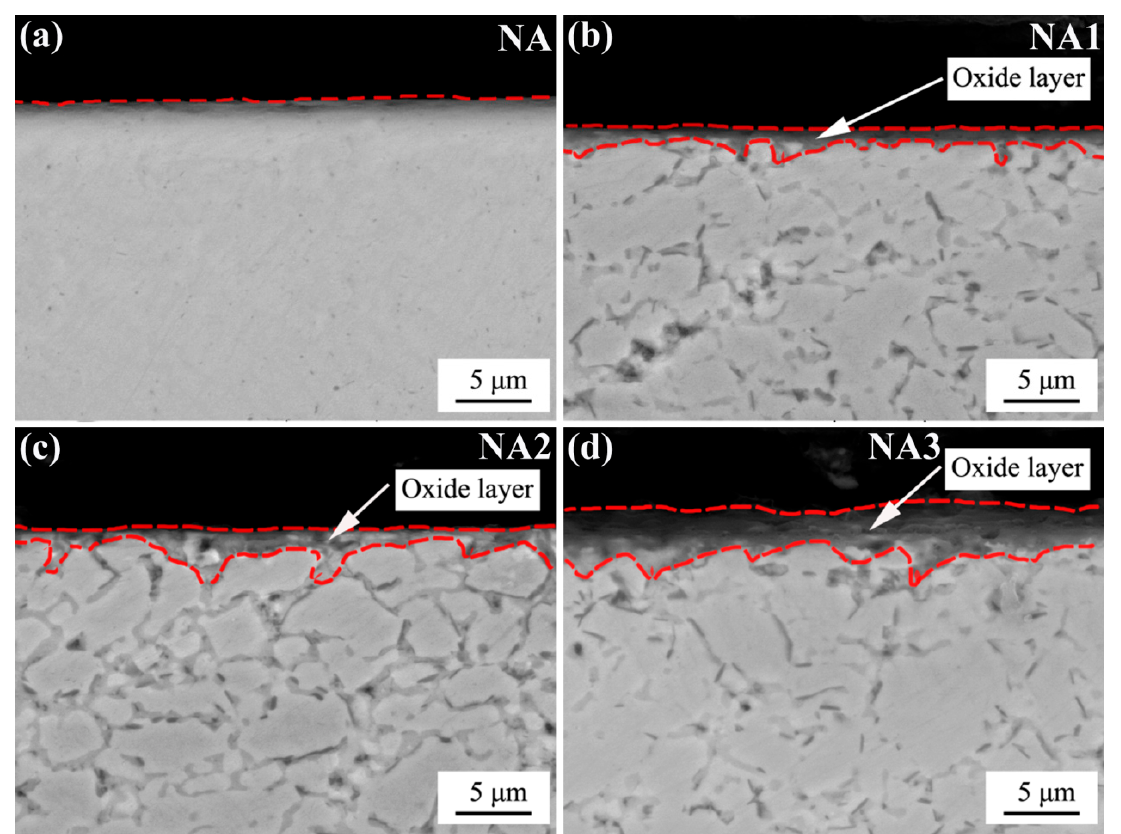
Figure 7. Oxidation cross-sectional morphologies of all composites: ( a ) NA; ( b ) NA1; ( c ) NA2; ( d ) NA3.